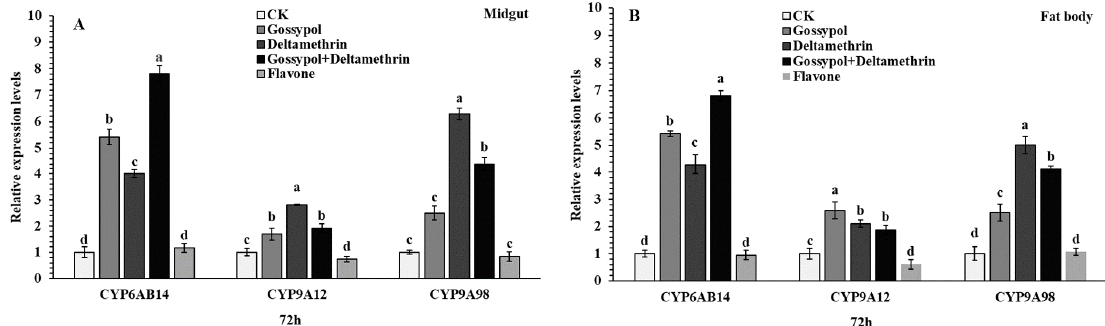
Figure 3. Effect of gossypol on beet armyworm tolerance to deltamethrin and relative expression levels of three P450s genes in midgut ( A ) and fat body ( B ) of S. exigua . Late third instar larvae were transferred into new sterilized plastic cups containing artificial diets supplemented with 0.1 % gossypol, LC 50 concentration of deltamethrin 0.887mg/L for 72 h or 0.1 % gossypol for 24 h followed by deltamethrin for 72 h. Data shown are means ± SE derived from three biological replicates. The transcription levels of three P450s genes determined by quantitative real-time PCR, normalized to three reference genes Different letters above bars indicate significant differences ( p < 0.05) according to the Tukey HSD test.